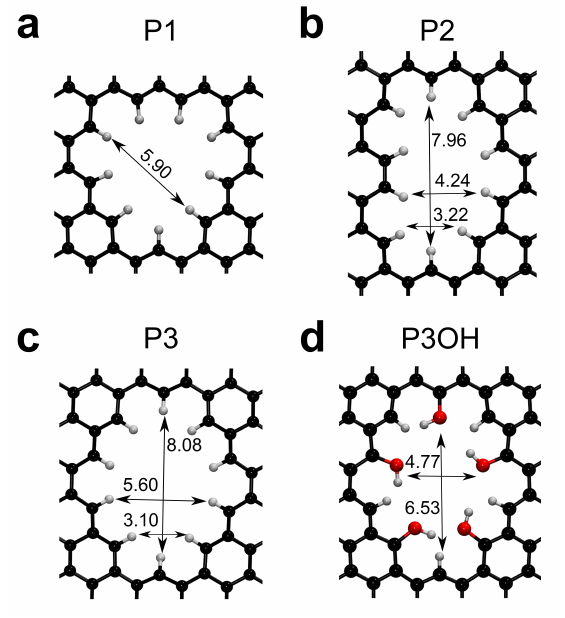
Figure 2. Ball and stick representation of the porous graphene structures employed for gas separation (zoomed on the pore area). Carbon atoms are represented in black, oxygens in red and hydrogens in white. Distances are in Angstrom.